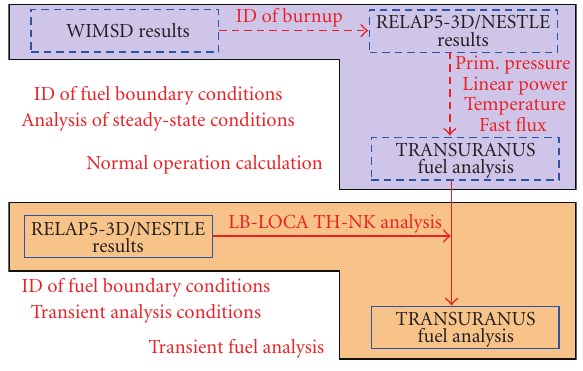
Figure 7: Outline of code